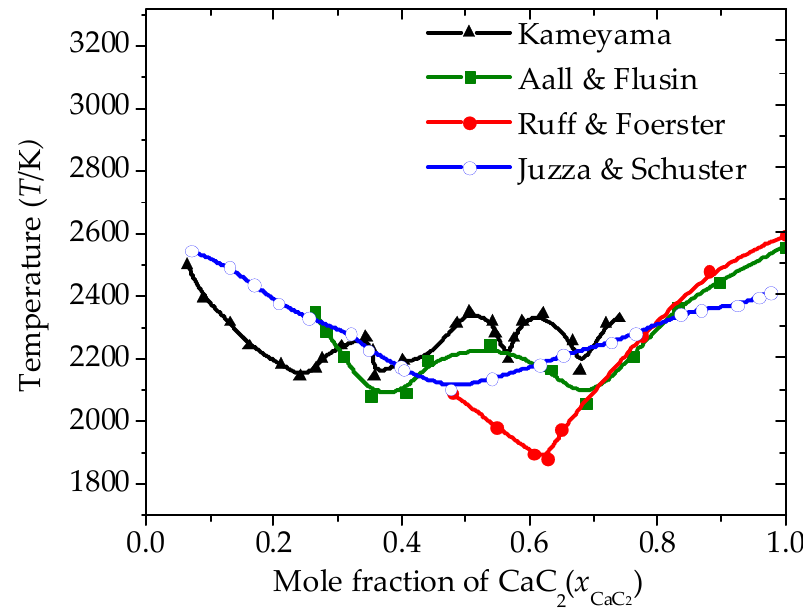
Figure 1. Phase diagram of the CaC 2 -CaO binary system.